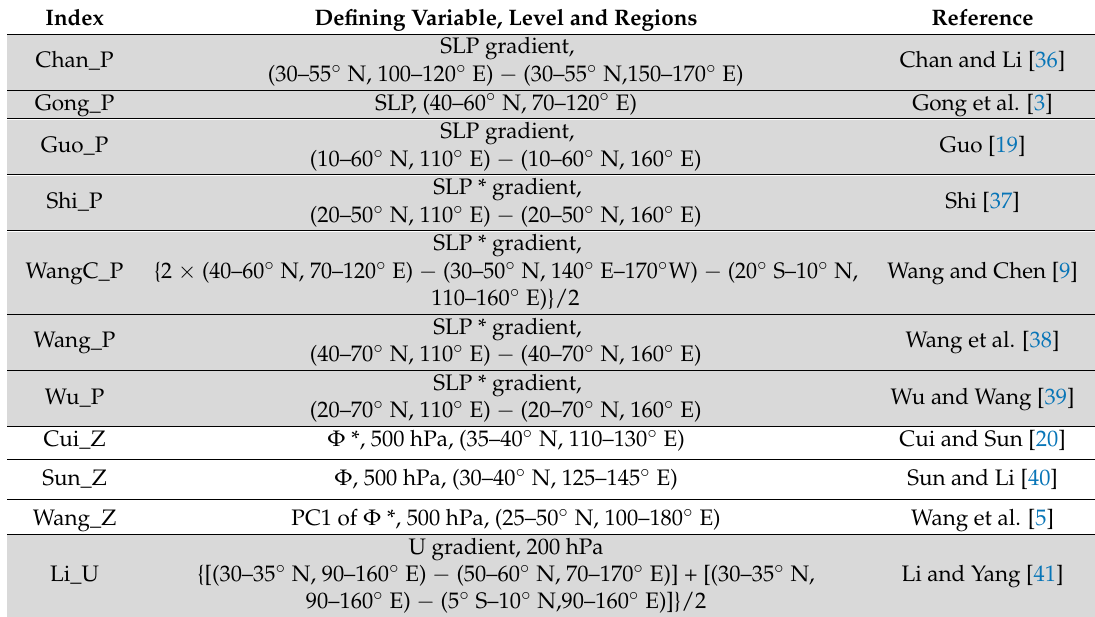
Figure 1. Normalized December, January and February (DJF)-mean East Asian winter monsoon (EAWM) indices for the period 1983–2007. Two dotted lines indicate ± 0.5 std dev. Table 2. Description of the 11 EAWM indices used in this study. Here, SLP: sea level pressure, U: zonal winds and Φ : Geopotential height. Superscript * denotes the normalized